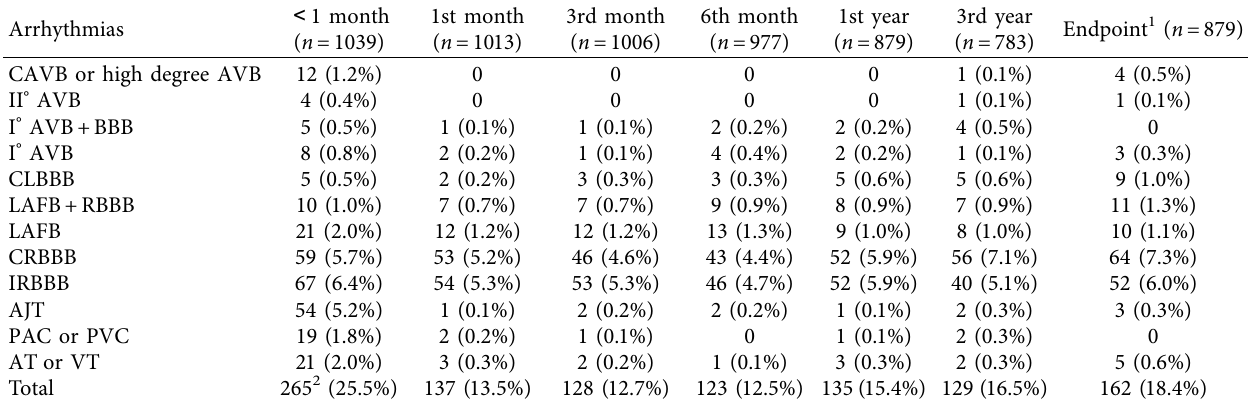
Table 2: The morbidity of various types of arrhythmias during follow-up. Arrhythmias